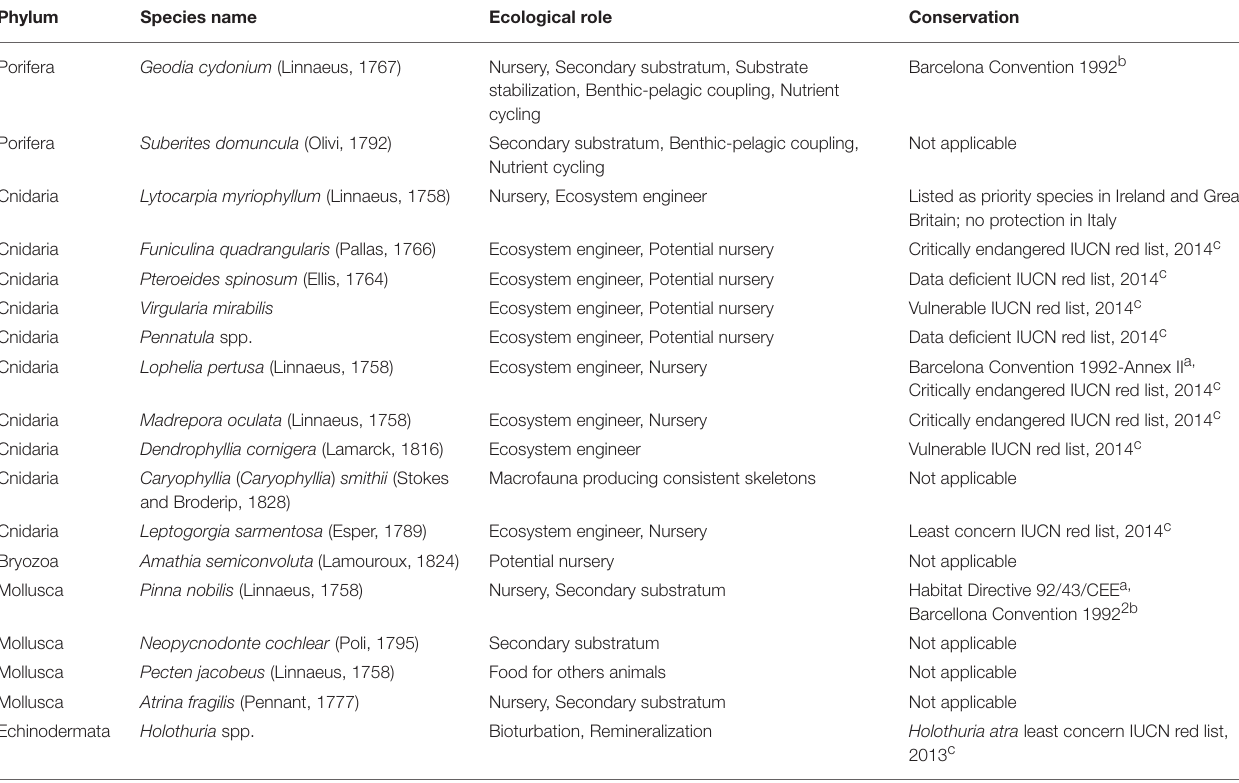
TABLE 1 | List of the selected megabenthic species for which we asked fishers to provide qualitative abundances in the central Adriatic Sea, with the ecological, and functional role played by each species and their conservation status.